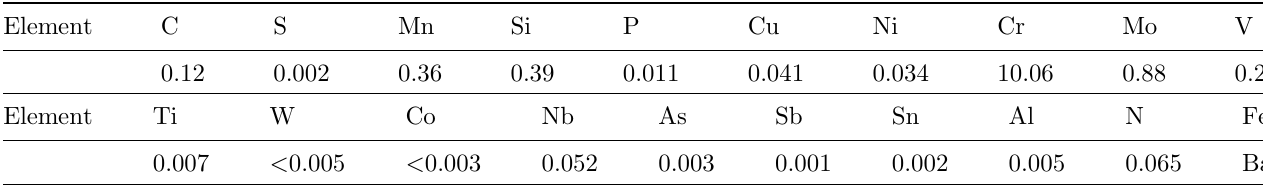
Table 4. Chemical composition steel P91